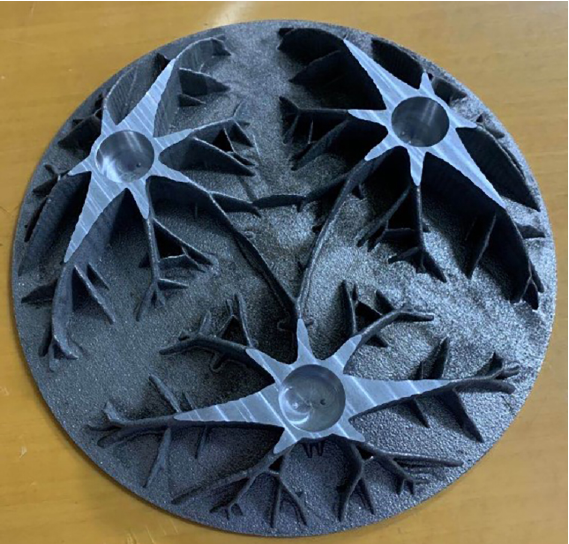
Figure 9. The Φ 260 mm aperture mirror blank using SLM-based additive-manufacturing technology.